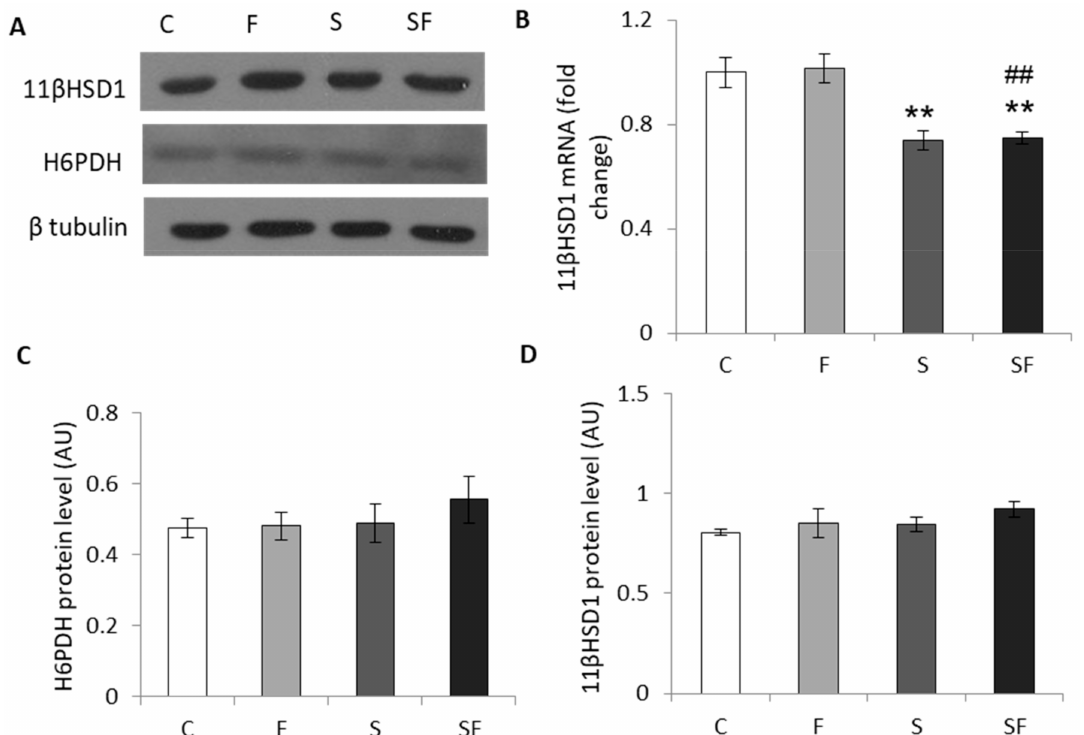
Figure 4. Glucocorticoid prereceptor metabolism in skeletal muscle of control (C), fructose (F), stress (S), and stress + fructose (SF). Representative Western blots ( A ) of protein levels of 11 β HSD1 ( D ) and H6PDH ( C ) in the muscle tissue ex- tracts. The values represent the mean ± SEM for each protein normalized to β tubulin expressed in arbitrary units (AU). 11 β HSD1 mRNA level ( B ) compared to HPRT mRNA was determined by TaqMan real-time PCR in the skeletal muscle. The values represent the mean ± SEM ( n = 8–9 animals per group). All measurements were done in tripli- cate. Significant between-group differences from post hoc Tukey test are given as follows: ** p < 0.01, S, SF vs. C; ## p < 0.01, SF vs. F. 11 β HSD1—11 β hydroxysteroid dehydrogenase type 1; H6PDH—hexose-6-phosphate dehydrogenase; HPRT—hypoxanthine